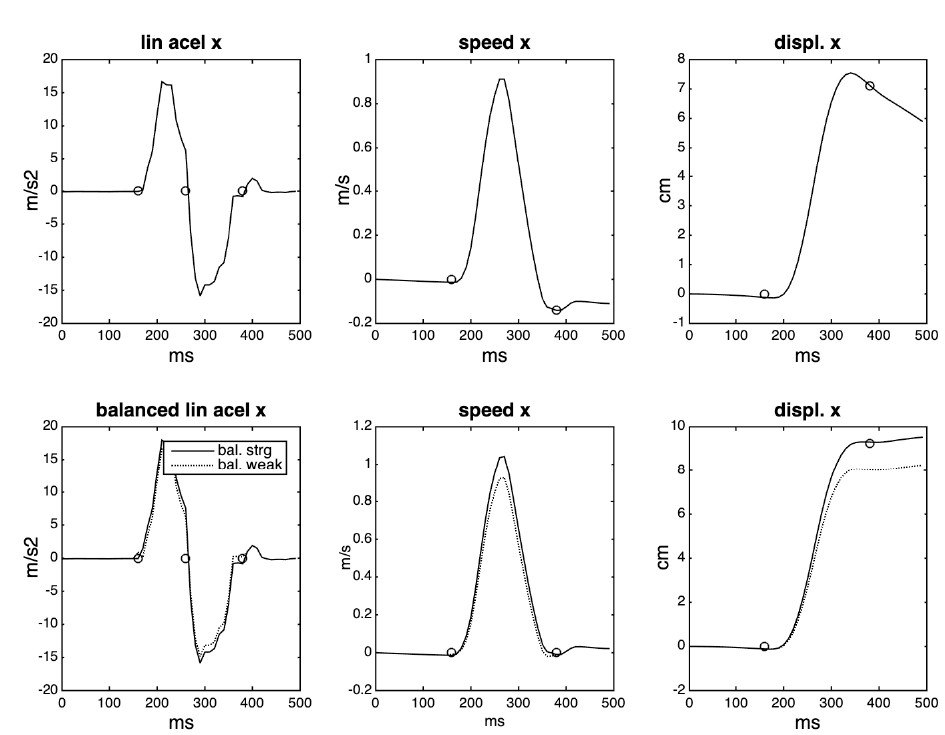
Figure 5. Double integration of the acceleration curve of a simple linear trajectory. On the second row, the solid line indicates a balance towards the strong lobe, the dashed line a balance towards the weaker lobe. The small circles indicate the zero-crossings extracted from the acceleration